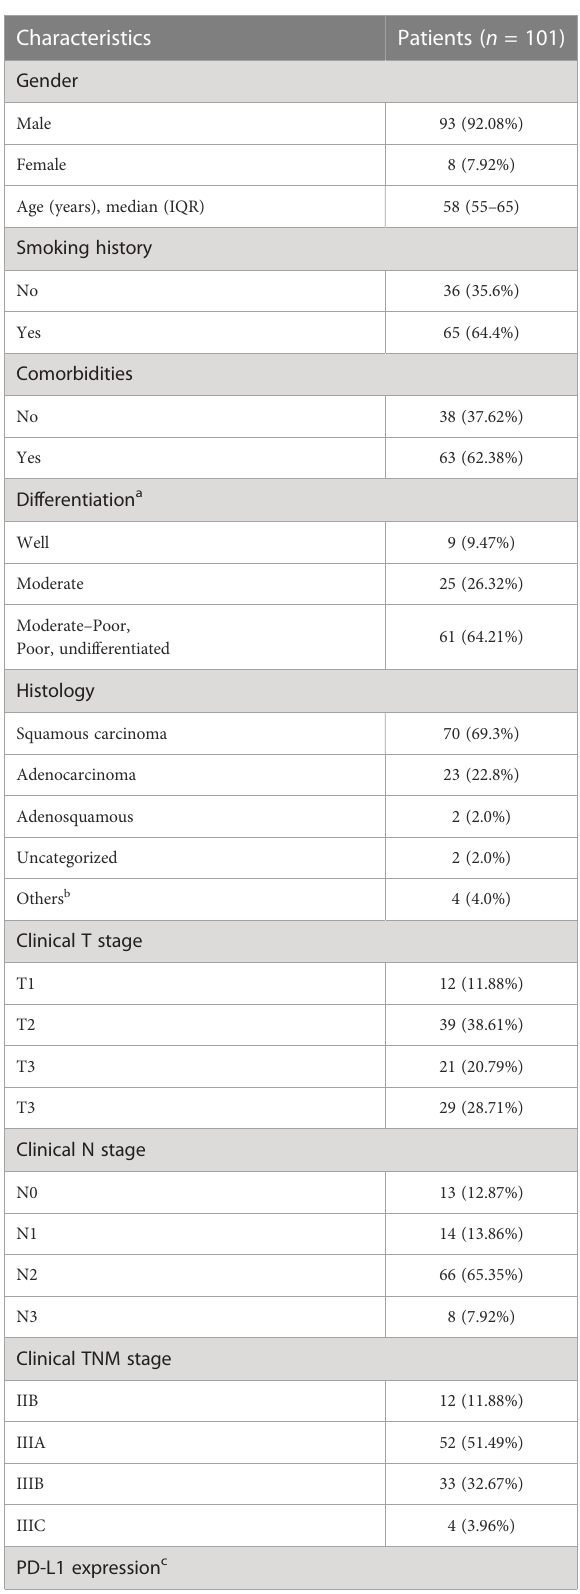
TABLE 1 Clinicopathological